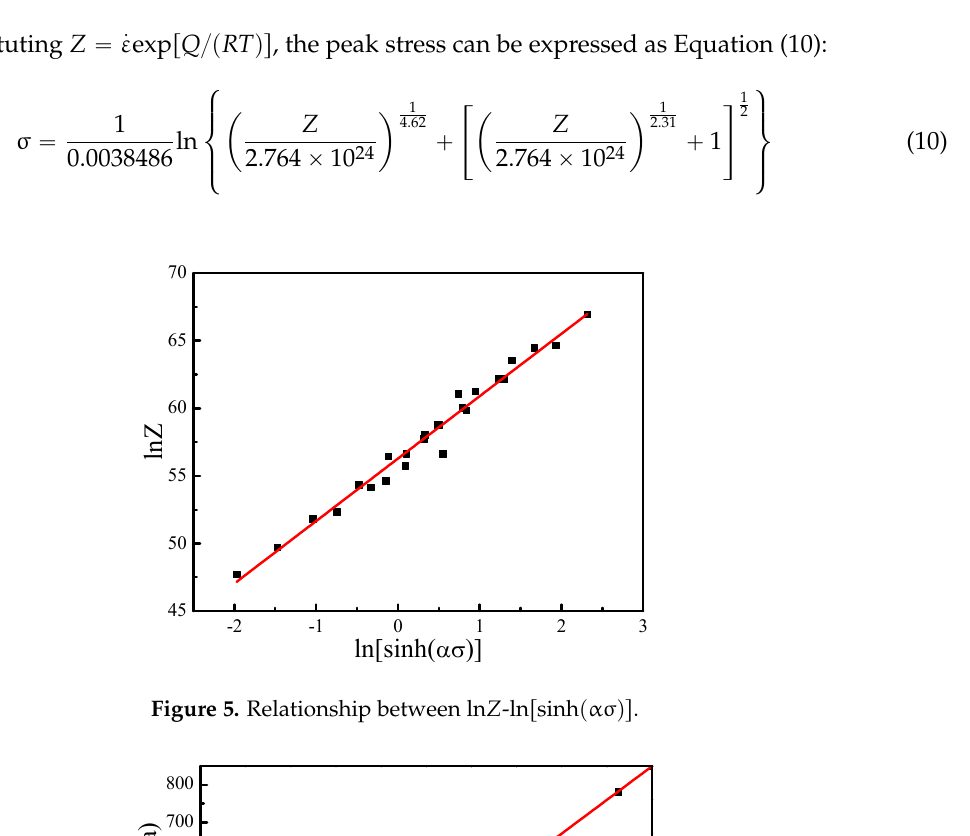
Figure 7. Schematic of the work ‐ hardening rate versus flow stress [22]. I